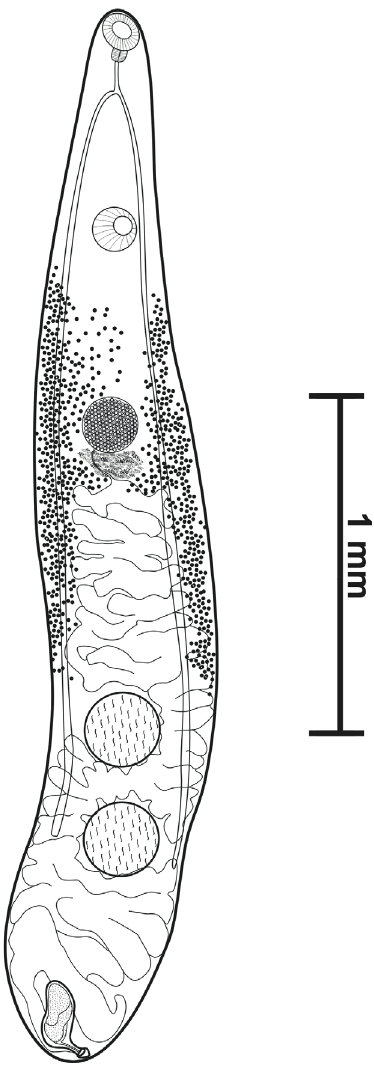
Figure 2 - Urotrema scabridum Braun 1900 found in Eumops glaucinus (Wagner,